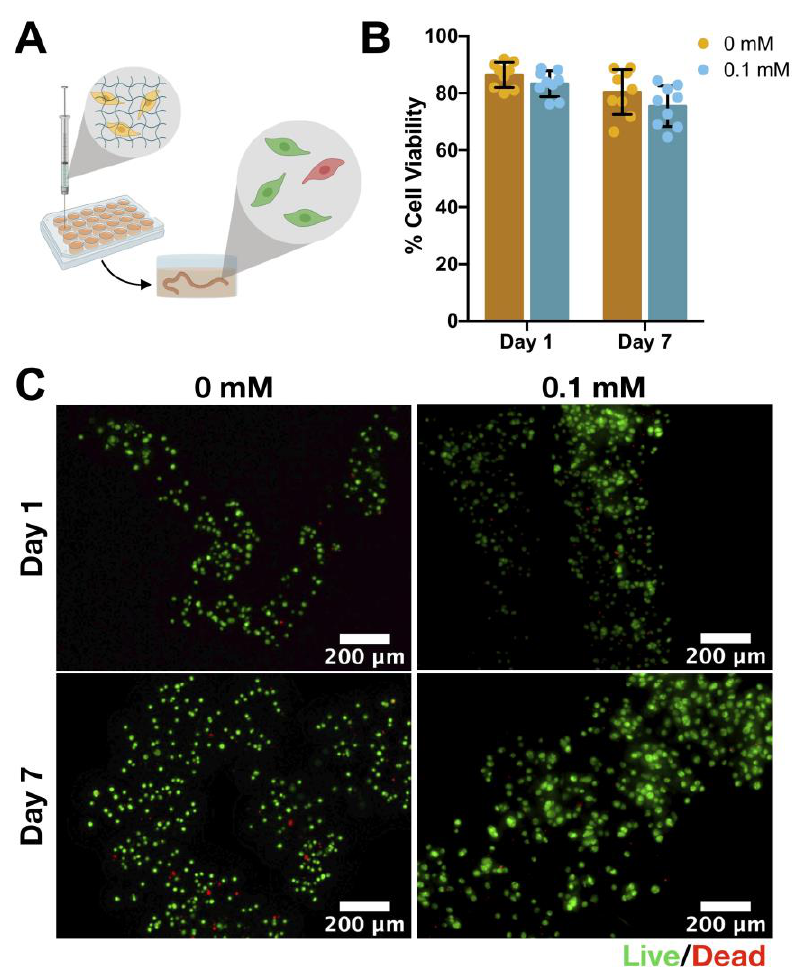
Figure 3. Cell encapsulation within Mn-based GG-MA hydrogel fibers. ( A ) Schematic representation of the experimental outline. Cells were injected directly into aCSF using a Hamilton syringe coupled with a 31G needle, and then cultured for different periods of time; ( B ) cell viability after 1 and 7 days of encapsulation in hydrogels with 0.1 mM MnCl 2 and GG-MA only (used as control). Results presented as average ± SD, n = 3; ( C ) fluorescence microscopy images of Live/Dead staining after 1 and 7 days of incubation. Live cells showed as green and dead cells as red. Scale bar: 200 µ m. Schematic representation created with BioRender.com.